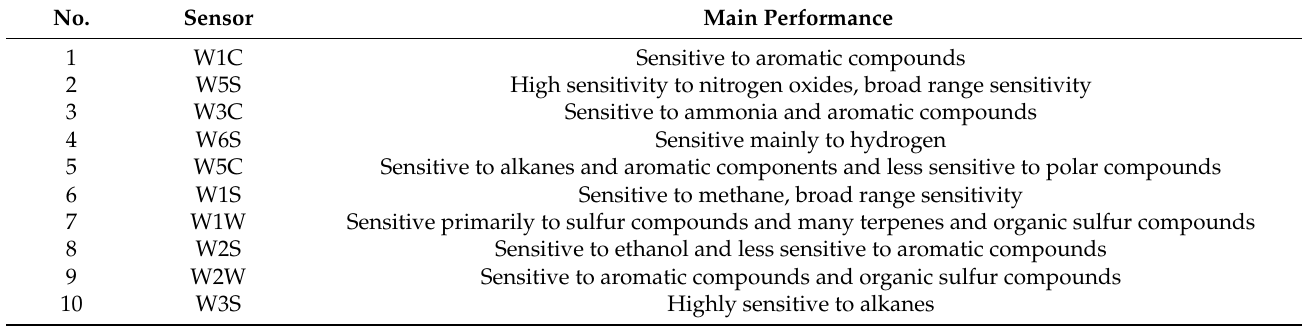
Table 2. Details of the 10 sensors in the